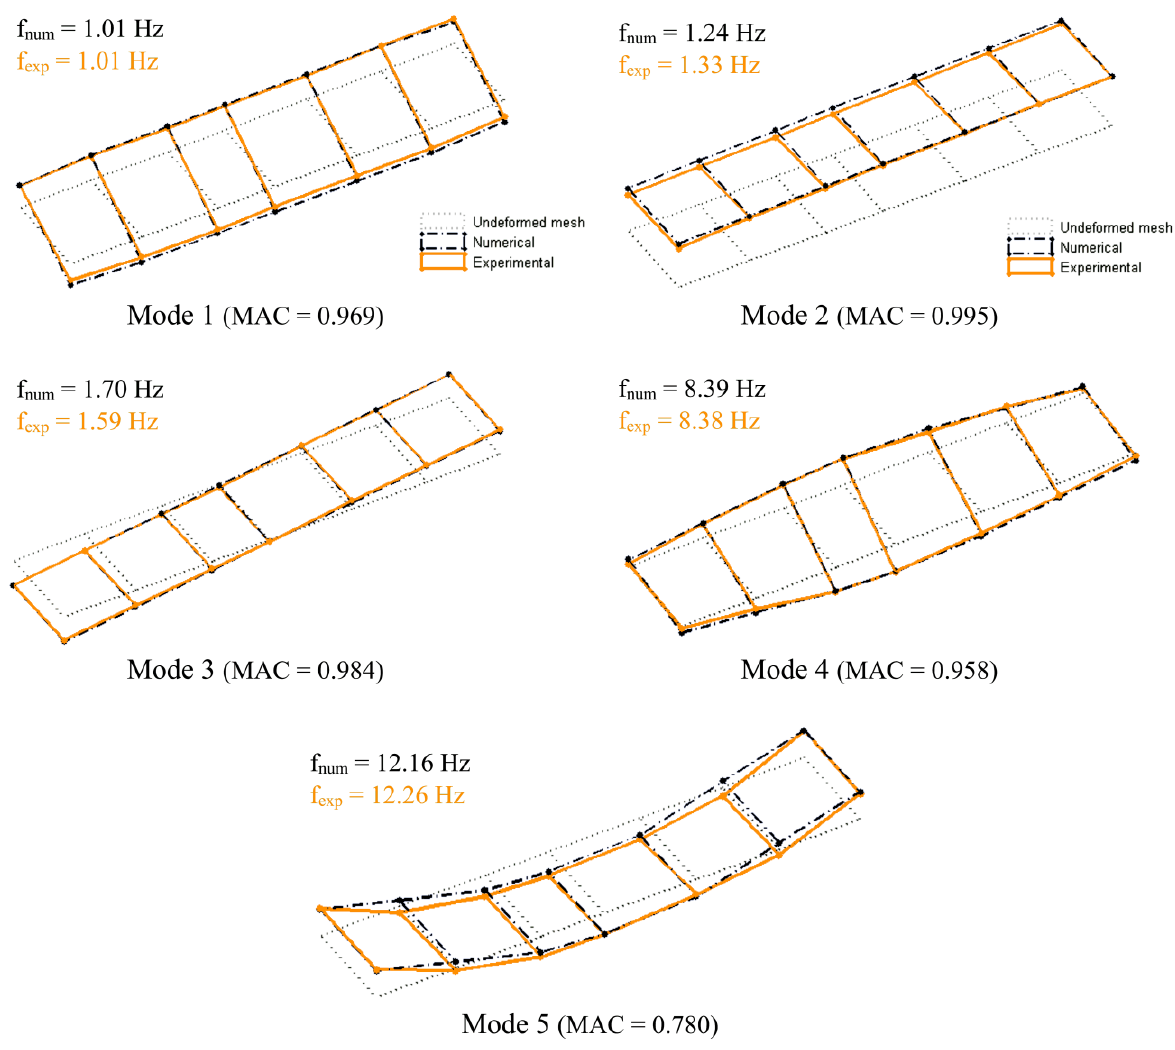
Figure 10. Comparison of the vibration modes of the BBN vehicle obtained experimentally and